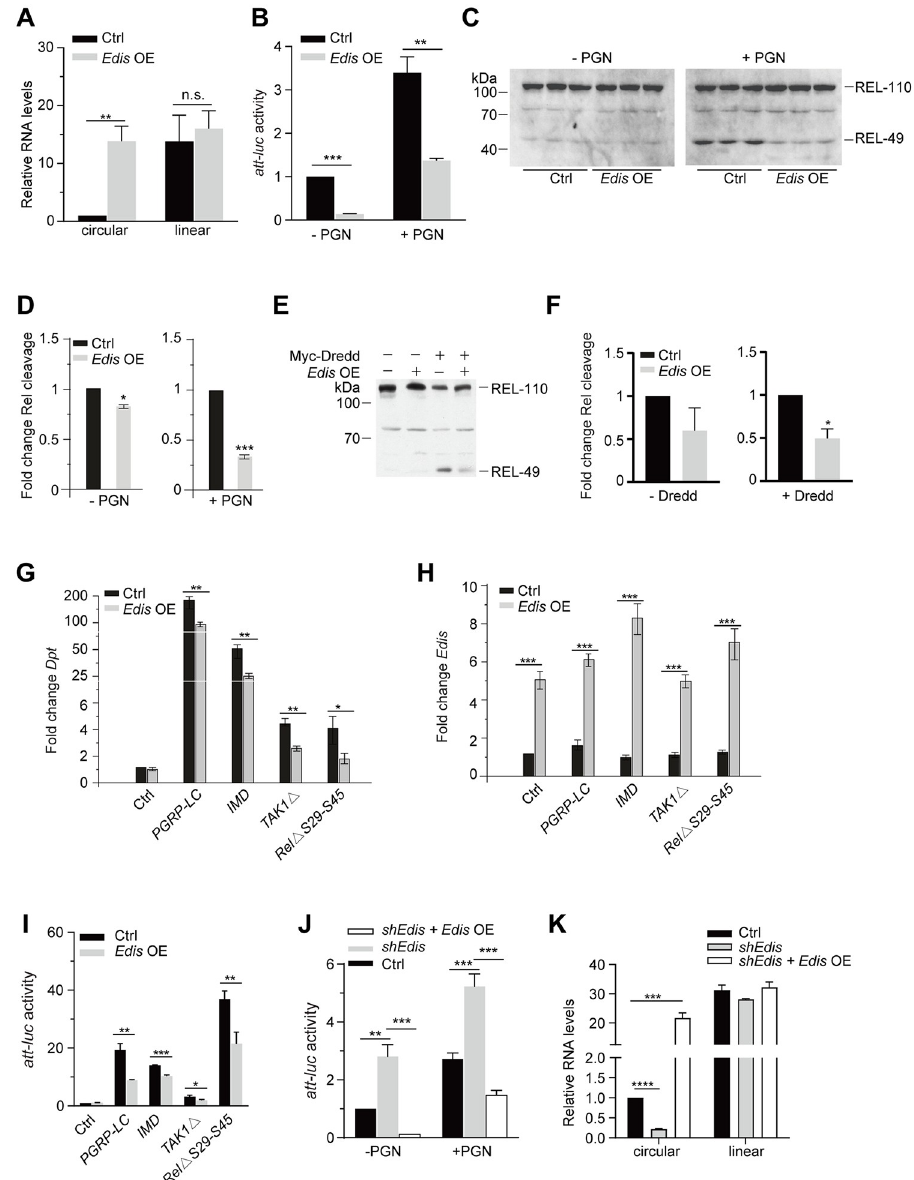
Fig 2. Edis overexpression blocks IMD innate immunity signaling. ( A-D ) S2 cells were transfected with an Edis expression construct or empty vector, together with the Att-luc reporter and the pActin-Renilla control reporter. Cells were treated with 20-HE and PGN. Levels of Ect4 and Edis ( A , student t test, n = 3, ��� p < 0.001; ns, non-significant), normalized reporter activity ( B , student t test, n = 3, �� p < 0.01; ��� p < 0.001), and Relish processing ( C ) are shown. Quantification of Relish processing immunoblot in C is shown in D (student t test, n = 3, � p < 0.05; ��� p < 0.001). ( E-F ) A stable S2 cell line expressing Myc-tagged Dredd under the control of the copper-inducible metallothionein promoter was transfected with either the expression vector for Edis or the control empty vector. Cells were first treated with and 20-HE. Subsequently, cells were treated with copper to induce transgene expression, or left untreated. Relish processing was measured by immunoblot (a representative image of three independent experiments is shown). Quantification of Relish immunoblot is shown in F (student t test, n = 3, � p < 0.05). ( G-H ) S2 cells were transfected with various combinations of expression constructs for IMD signaling components (below), together with Edis overexpression or empty vectors. Cells were treated with 20-HE and levels of Dpt mRNA ( G ) and Edis ( H ) were measured (student t test, n = 4, � p < 0.05; �� p < 0.01; ��� p < 0.001). ( I ) S2 cells were transfected with various combinations of expression constructs for IMD signaling components (below), together with Edis overexpression or empty vectors and the Att-luc reporter and the pActin-Renilla control reporter constructs. Cells were treated with CuSO 4 and 20-HE and reporter activity was measured and shown (student t test, n � 4, � p < 0.05; �� p < 0.01; ���